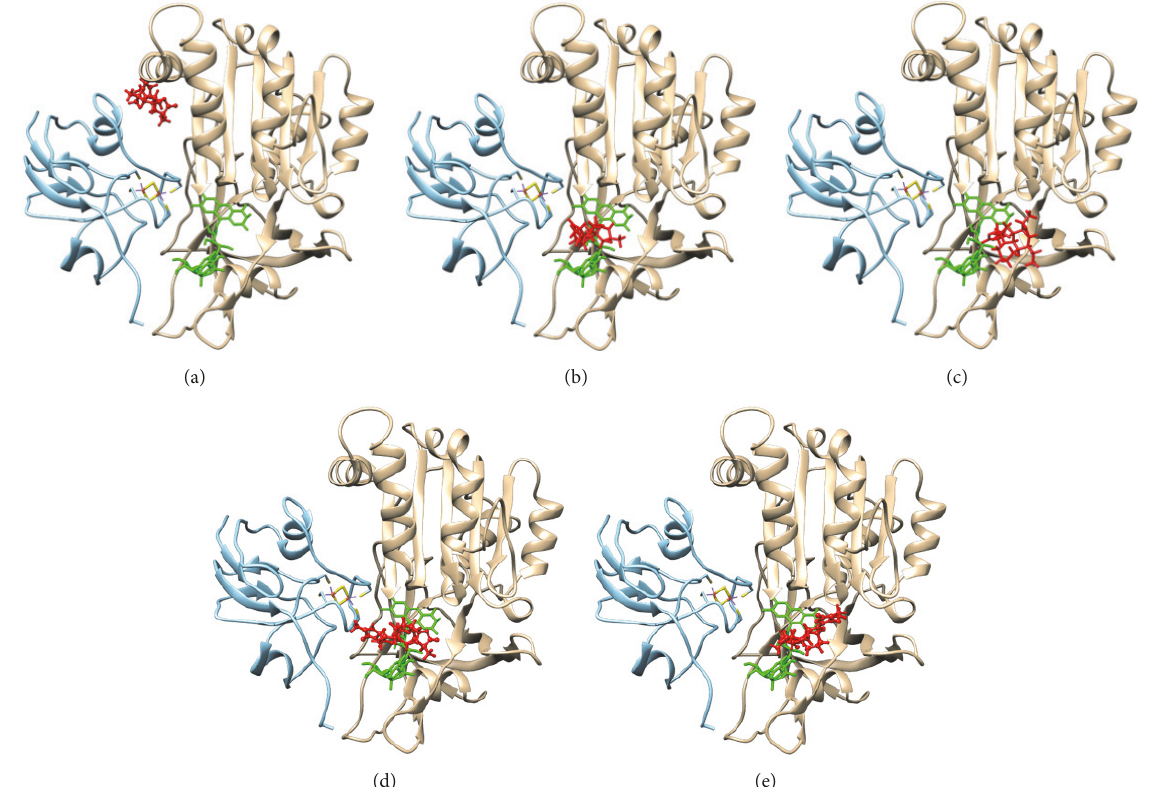
Figure 3: Interaction between receptors of Fd (blue), FNR (brown), and ligand (red): (a) croomine, (b) Epi -croomine, (c) tuberstemonine, (d) isoprotostemonine, and (e) javastemonine